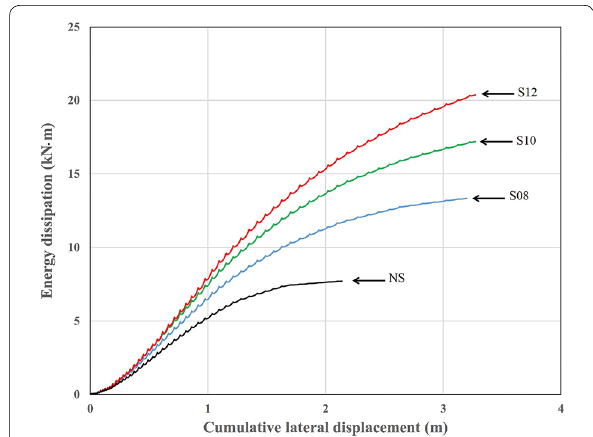
Fig. 9 Energy dissipation of specimens.